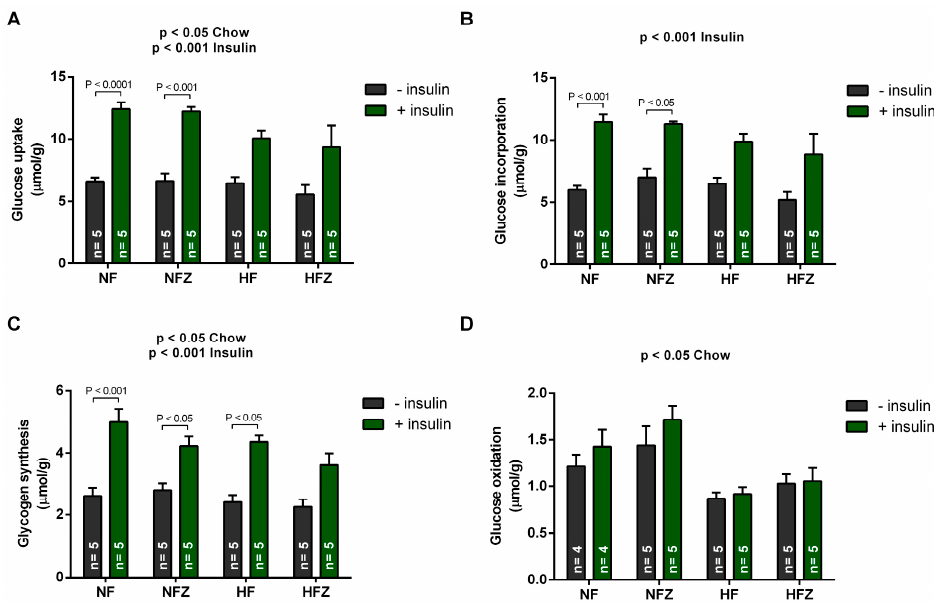
Figure 4. Uptake and metabolism of glucose in the soleus muscle. Glucose uptake ( A ), glucose incorporation ( B ), glycogen synthesis ( C ) and glucose oxidation ( D ) were assessed in the soleus muscle. Two-way ANOVA: glucose uptake (chow, p < 0.05; insulin, p < 0.01; interaction, p > 0.05); glucose incorporation (chow, p > 0.05; insulin, p < 0.01; interaction, p > 0.05); glycogen synthesis (chow, p < 0.05; insulin, p < 0.01; interaction, p > 0.05); and, glucose oxidation (insulin, p > 0.05; chow, p < 0.01; interaction, p > 0.05).